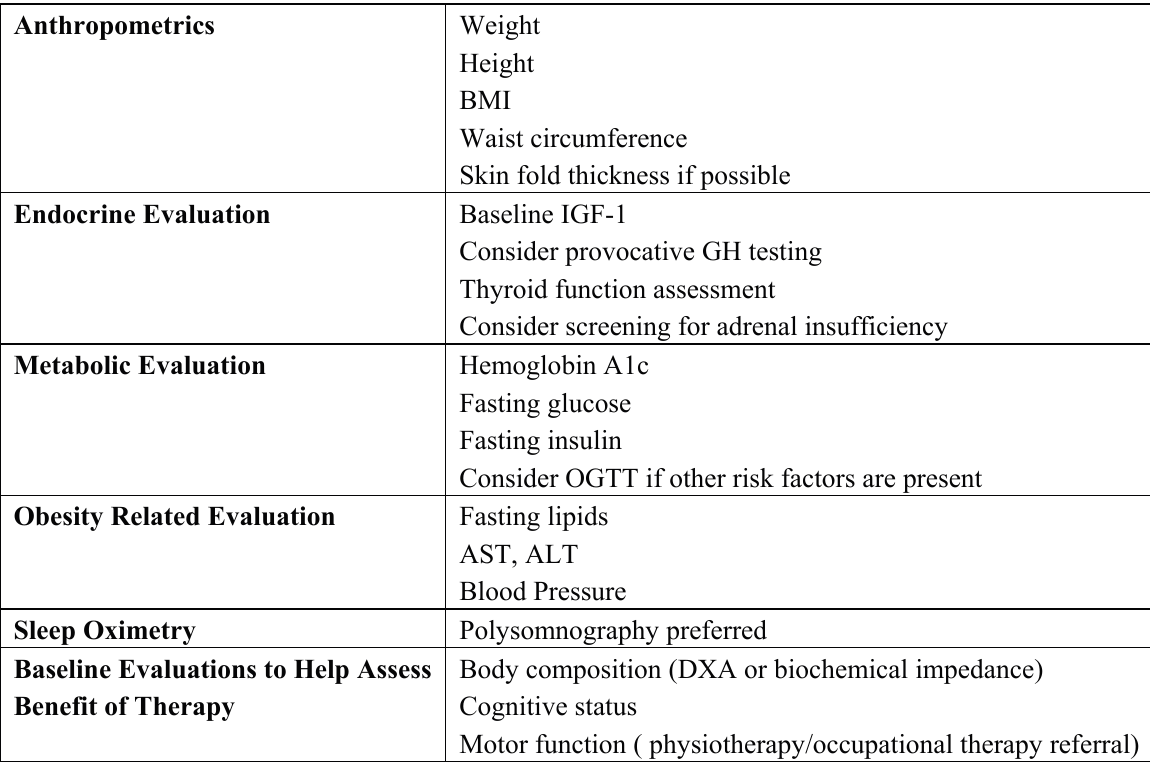
Table 1. Recommended evaluation prior to initiation of growth hormone therapy (hGH) in adults with Prader-Willi syndrome (PWS)